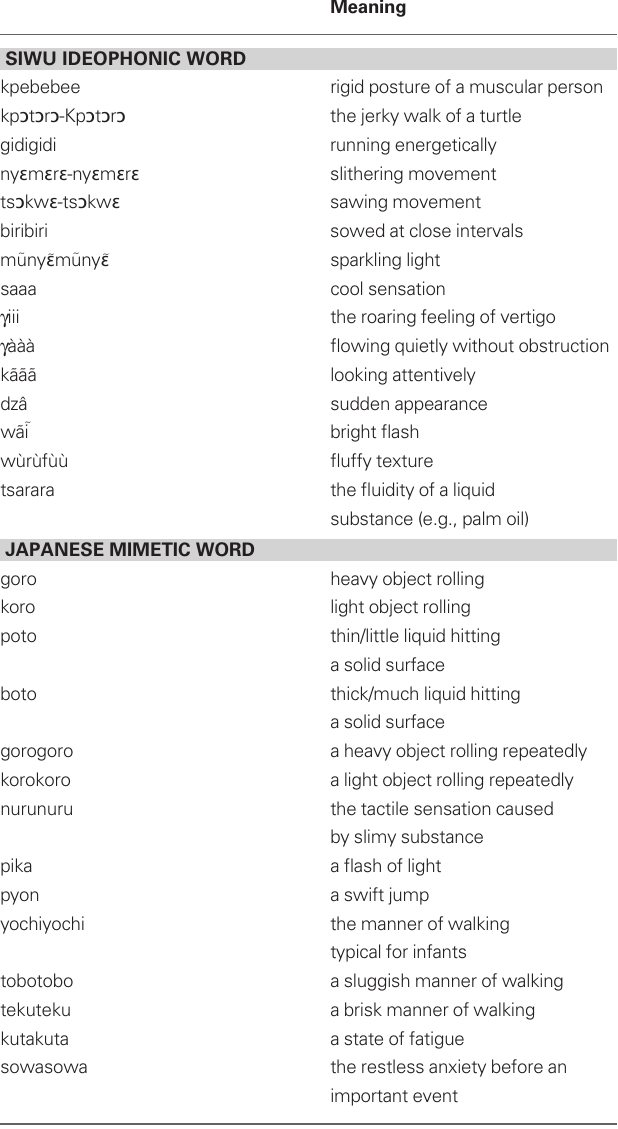
Table 1 | Examples of sound-symbolism in Siwu and